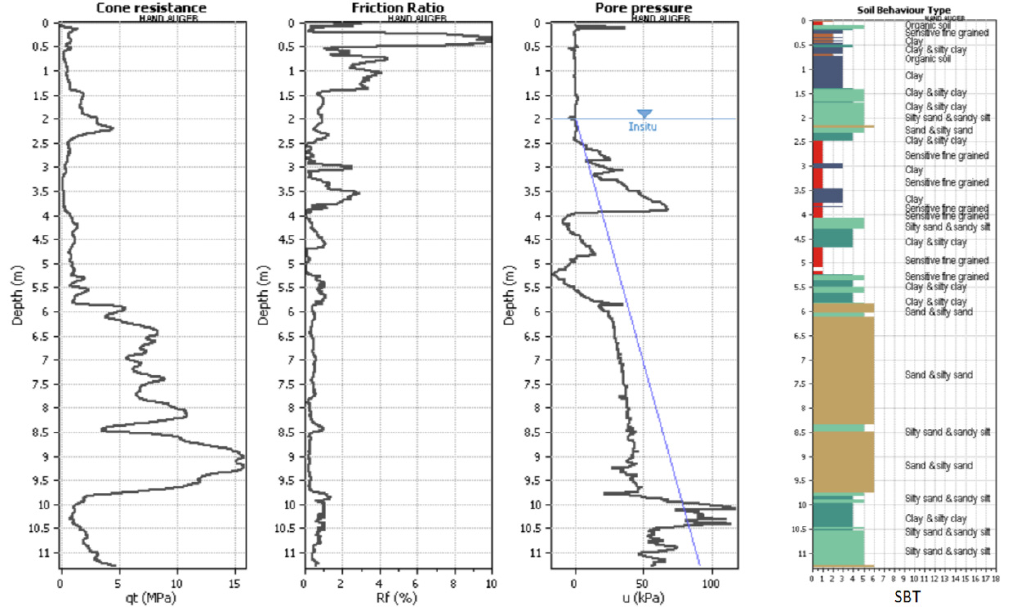
Figure 15. CPT characterization and SBT plot for Site 2-2 (after Anderson [40]).